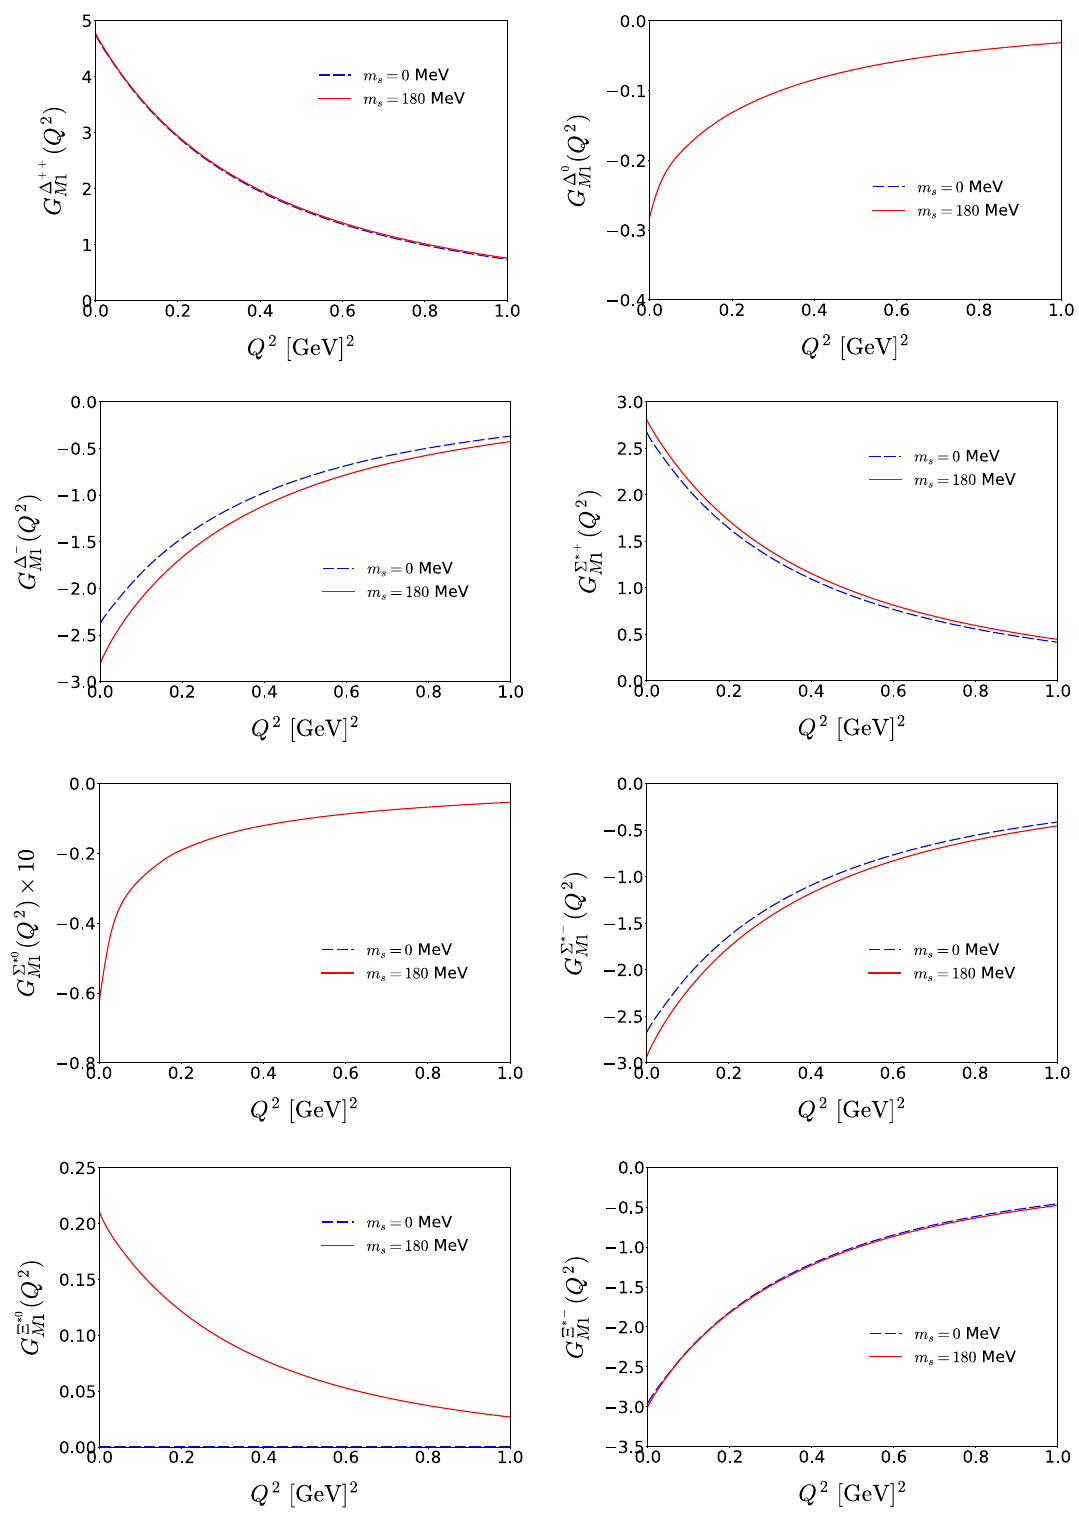
Fig. 10 Effects of the explicit flavor SU(3) symmetry breaking on the magnetic dipole form factors of the baryon decuplet except for the (cid:2) + and (cid:5) − baryons. Notations are the same as in Fig.